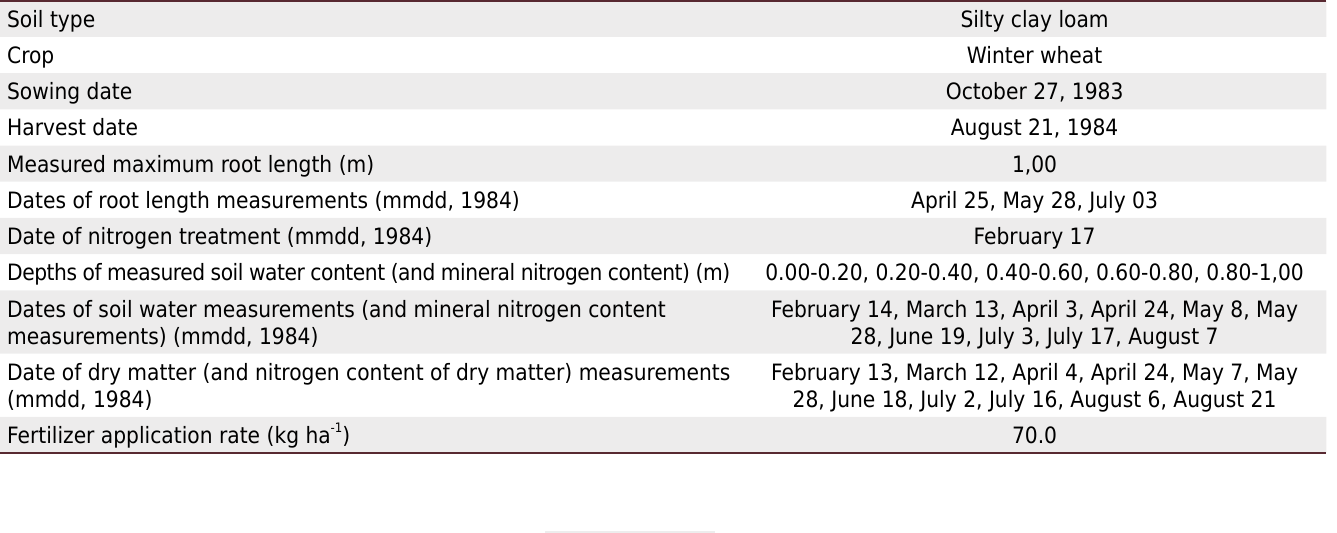
Table 1. Summary of the Bouwing experiment